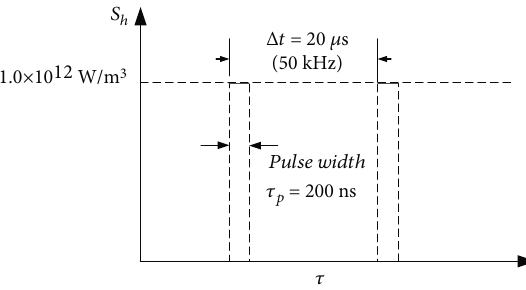
Figure 3: Schematic diagram of power density change with time as an energy source term.